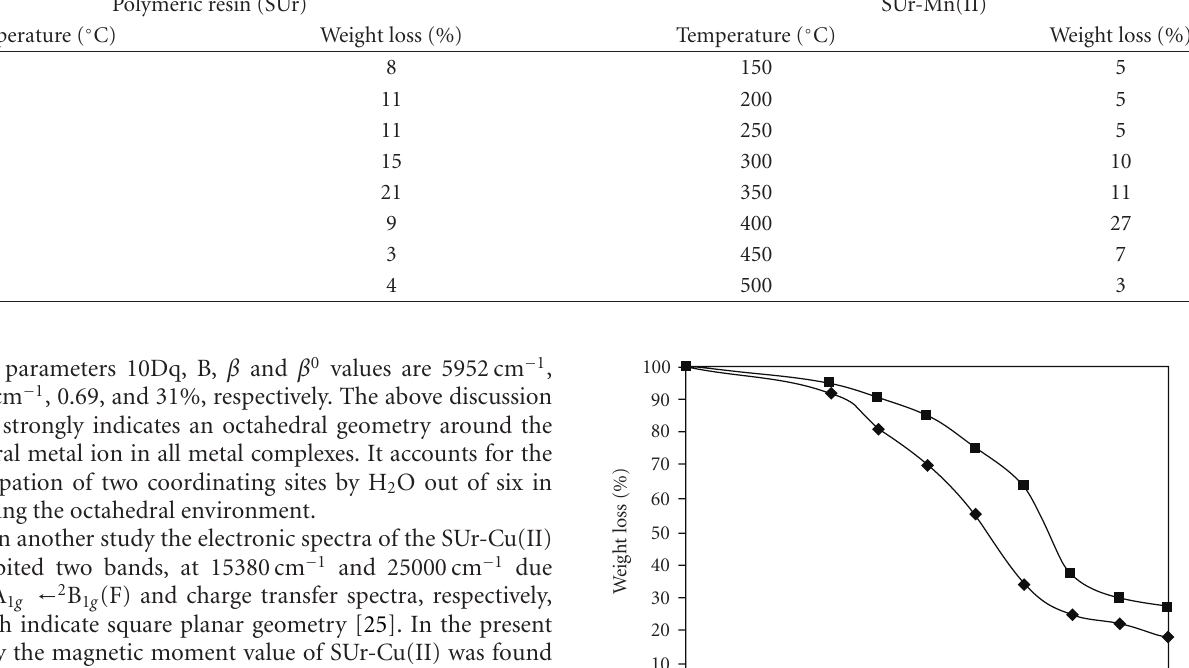
Table 6: Thermal behaviors of SUr and its polymer metal complex of Mn(II). Polymeric resin (SUr)